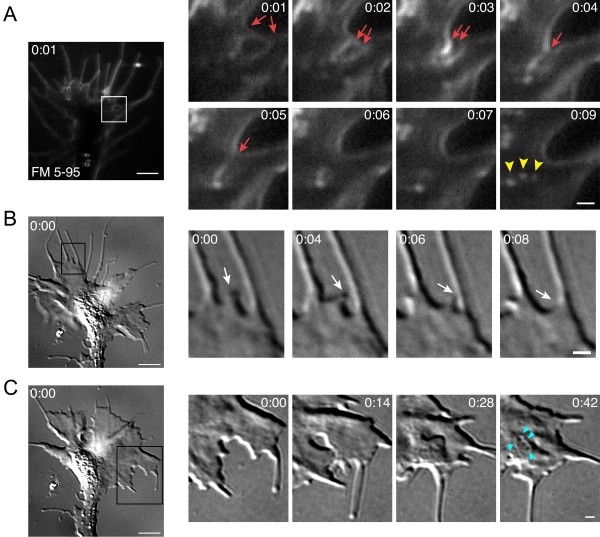
Small vesicle endocytic hot-spots triggered by lamellipodial contact. (A) Time-lapse confocal images of FM 5-95 internalization show an endocytic hot-spot where adjacent processes contact one another. The boxed area is magnified in the panels at the right and the time after the initial membrane labeling (mintes:seconds) is indicated in each frame. Lamellipodial contacts near the base of filopodia (red arrows) result in the formation of several small vesicles (yellow arrowheads) and subsequent membrane reshaping. For the corresponding time-lapse movie see Additional file 8. (B-C) Time-lapse DIC images show similar lamellipodial contacts and membrane remodeling as in (A). Note the contact between adjacent membrane processes (B, white arrows). The blue arrowheads indicate structures highly reminiscent of the reverse shadowcast vacuoles reported by Dailey and Bridgman [35]. See Additional file 9 for the time-lapse movie corresponding to Figure 6B, C. Scale bars, 5 μm (left), 1 μm (right).